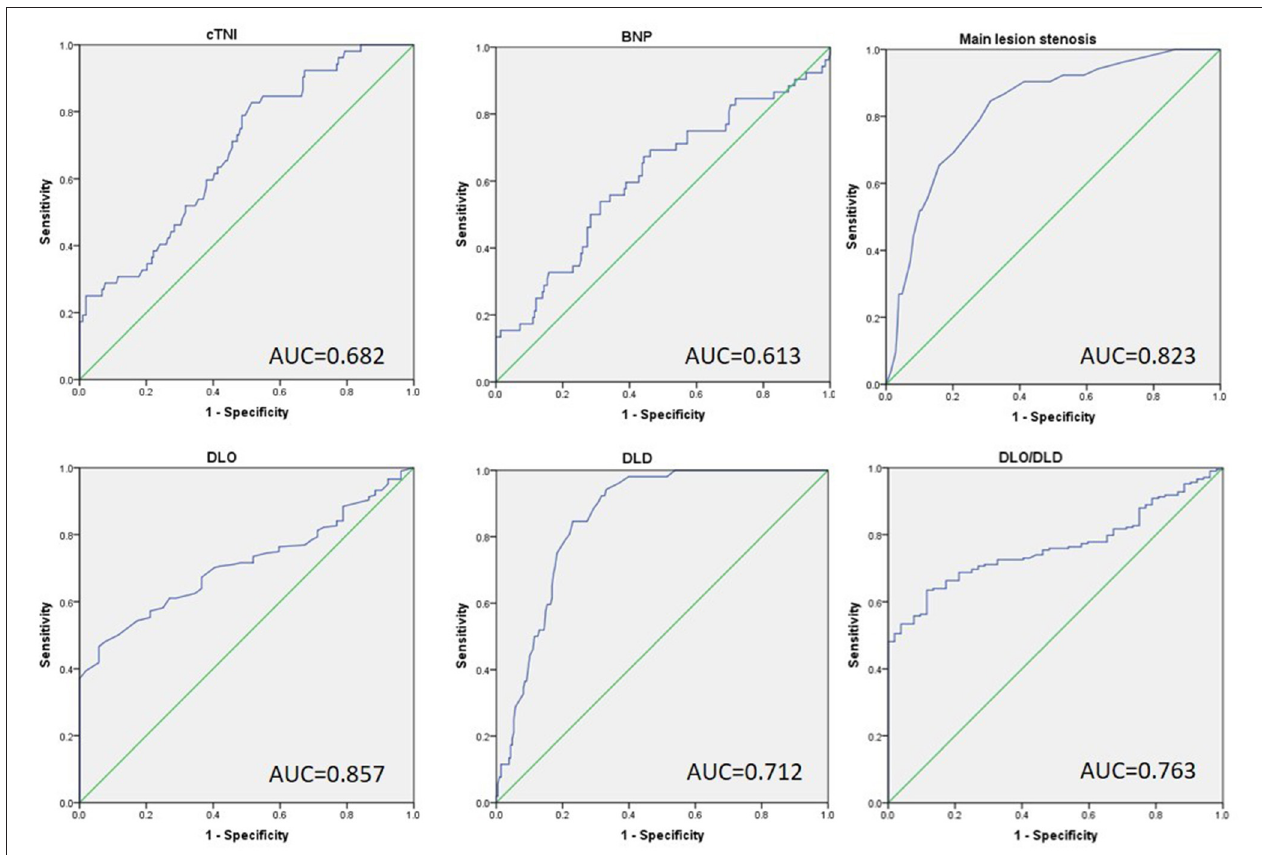
FIGURE 2 | The receiver operative characteristic curve of independent factors predicts the development of VA in patients with previous MI. cTNI max, max cardiac troponin I; BNP, brain natriuretic peptide; DLO, distance from lesion to ostia; DLD, distance from lesion to distal.